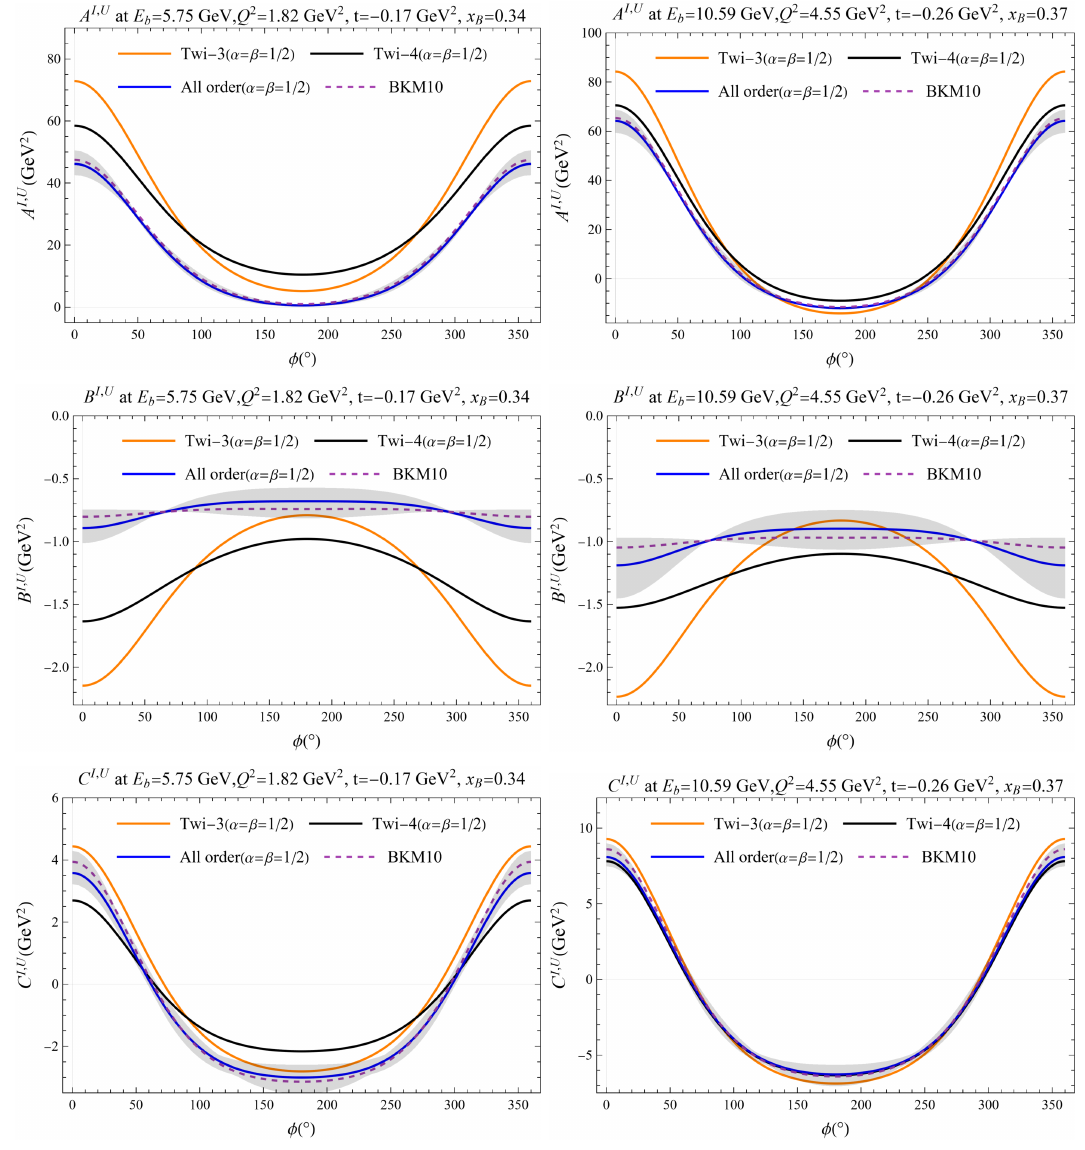
Figure 6 . Comparison of the coefficients A I, U , B I, U , C I, U from light cone calculation with the BKM10 result. The orange line stands for the results with only twist-three kinematical accuracy, the black line has twist-four kinematical accuracy, while the blue line contains kinematics of all order. The dashed line is the BKM10 result. The gray band consists of all possible values of those coefficients with 0 ≤ α ≤ 1 and 0 ≤ β ≤ 2